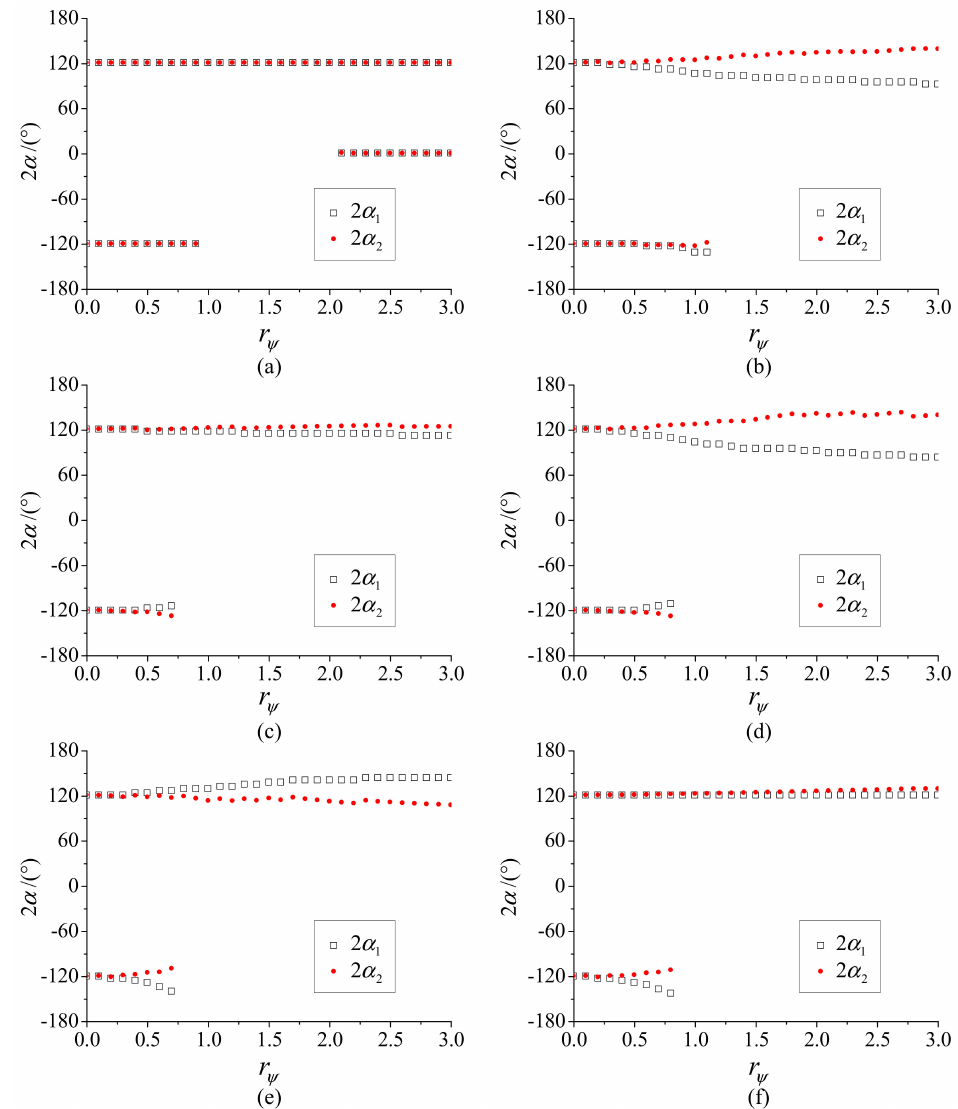
Figure 7. Stable phase differences of three ERs, l 1 = l 2 , β 3 = 270 ◦ : ( a ) l 1 = l 3 , β 1 = 30 ◦ , β 2 = 150 ◦ ; ( b ) l 1 = 2 l 3 , β 1 = 30 ◦ , β 2 = 150 ◦ ; ( c ) l 1 = l 3 , β 1 = 25 ◦ , β 2 = 155 ◦ ; ( d ) l 1 = 2 l 3 , β 1 = 25 ◦ , β 2 = 155 ◦ ; ( e ) l 1 = l 3 , β 1 = 45 ◦ , β 2 = 135 ◦ ; ( f ) l 1 = 2 l 3 , β 1 = 45 ◦ , β 2 = 135 ◦